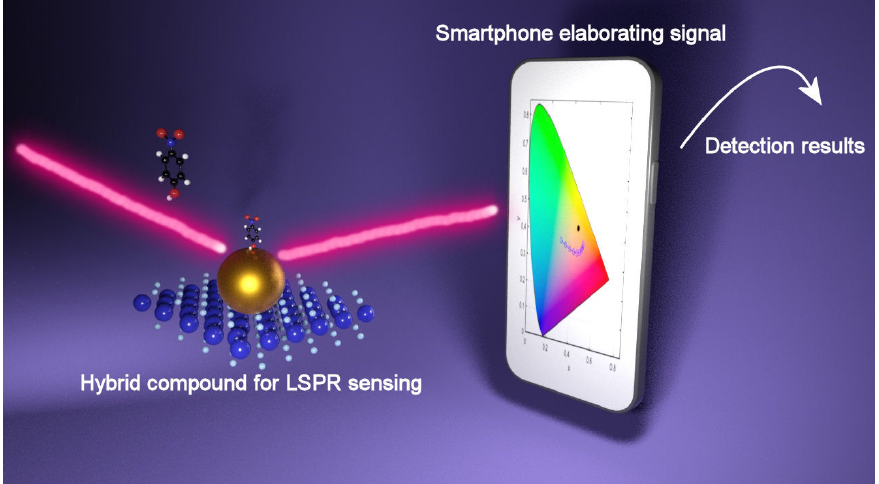
Figure 7. Recognition process of LSPR signal provided by smartphone (from Ref. [52]).